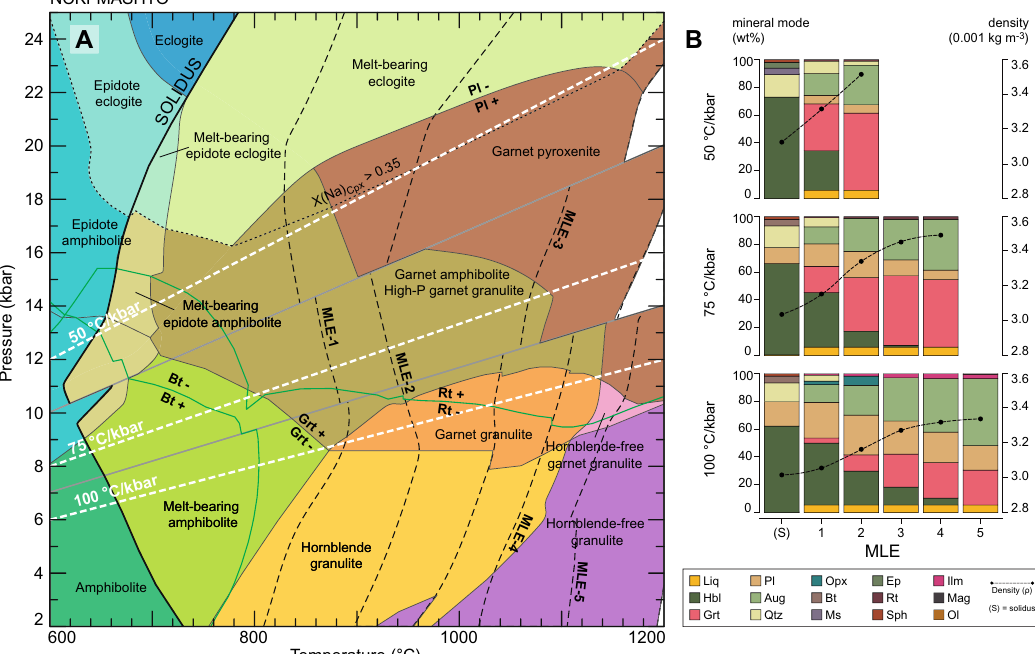
Figure 1. ( A ) Calculated P–T phase diagram for EAT showing the effects of melt fractionation during prograde metamorphism. Each melt loss event initiates at ~ 20 vol% of melt (black dashed lines) and phase relations calculated up-grade of this point are for a melt-depleted residuum. Geotherms are shown as dashed white lines. Dotted line marked X(Na) Cpx > 0.35 divides high-pressure amphibolite and granulite-facies assemblages from eclogite-facies assemblages based on clinopyroxene composition. ( B ) Modal mineralogy present in the residuum at the point of first melting and each MLE afterward. Dotted black lines represent the density of the residuum. Calculations were performed in the Na 2 O–CaO–K 2 O–FeO–MgO–Al 2 O 3 –SiO 2 –H 2 O–TiO 2 –O 2 (NCKFMASHTO) compositional system using Theriak-Domino software 24 (Version 11.02.2015). Mineral abbreviations are based on Whitney and Evans 25